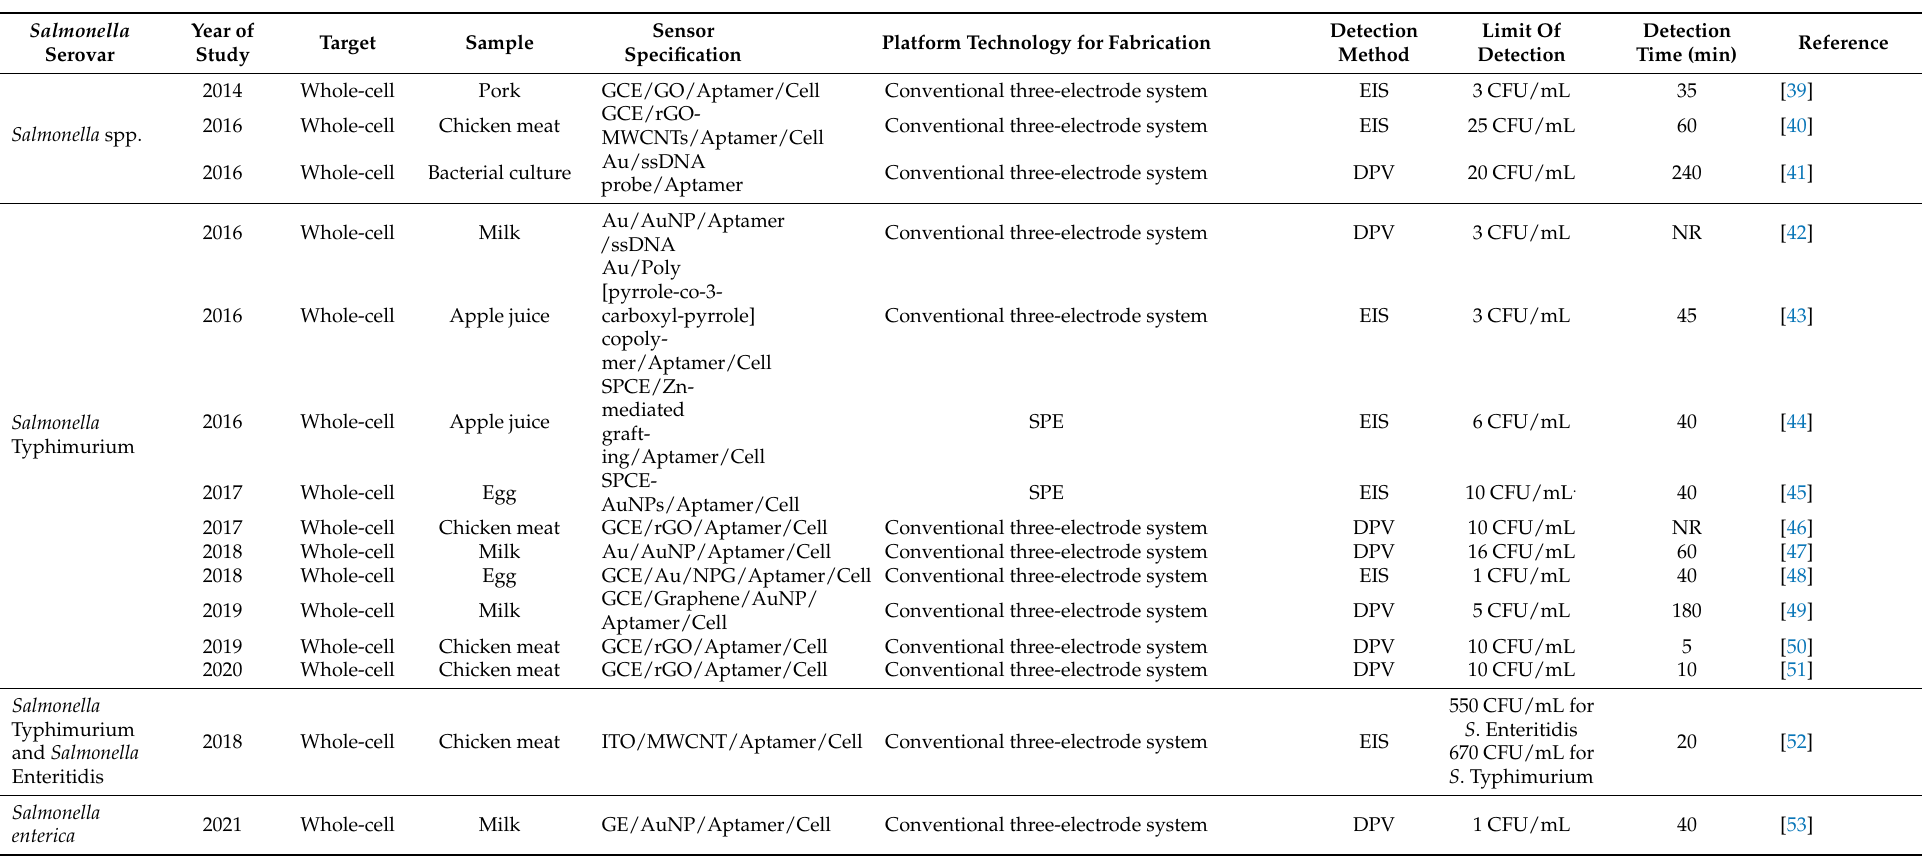
Table 1. Characteristics of included